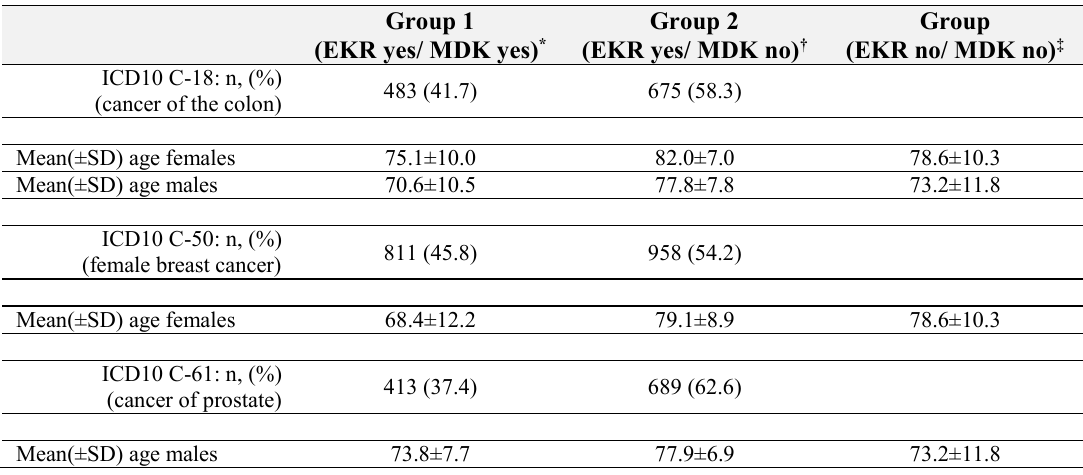
Table 2. Age distribution of MDK patients stratified by cancer location, grouped by cancer case status in cancer registry (EKR) and MDK database Group 1 Group 2